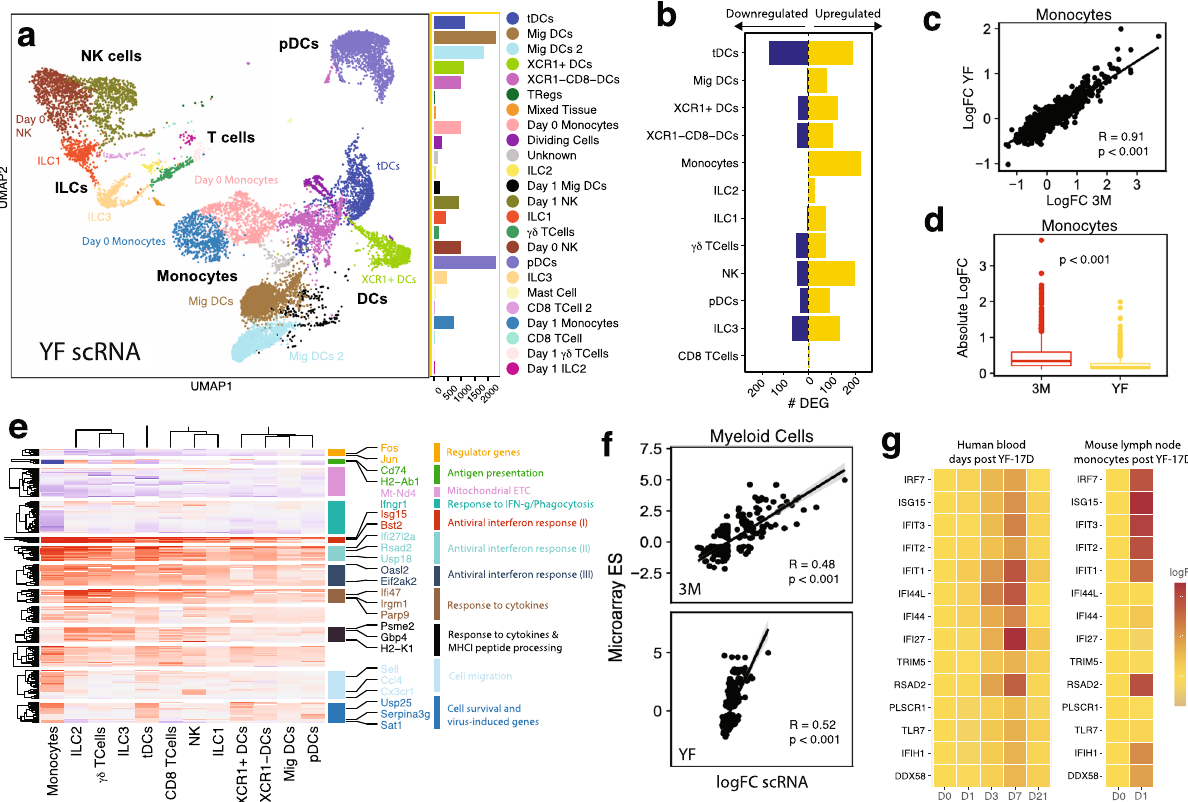
Fig. 3 3M-052-Alum/OVA induces a transcriptional signature on Day 1 similar to YF-17D. a UMAP embedding of 15,330 cells classi fi ed by cell type. b Number of upregulated (yellow) and downregulated (blue) genes in each celltype, FDR < 0.05 and absolute LogFC > 0.25. c Correlation of the logFC of 3M-052-Alum/OVA and YF across monocytes. R = Pearson ’ s correlation; p represents two-tailed P values. d Absolute logFC of each gene in monocytes in 3M (red) and YF (yellow) ( n = 20967). Statistical test performed was two-sided t-test. Center line of boxplot corresponds to the median, the bounds are the 75th and 25th percentiles (interquartile range; IQR), and the whiskers are the largest or smallest value no further than 1.5*IQR from the bounds. e Log fold change of genes from ( b ) across all cell types. f Correlation between the logFC of each gene in human samples 7 days after immunization with the logFC of the corresponding homolog in mouse myeloid cells 1 day after YF-17D immunization. R = Pearson ’ s correlation; p represents two-tailed P values. g Genes previously identi fi ed as signi fi cantly changing in humans after YF-17D immunization. Left, human transcriptional changes after YF-17D vaccination; Right, corresponding changes in mouse monocytes after